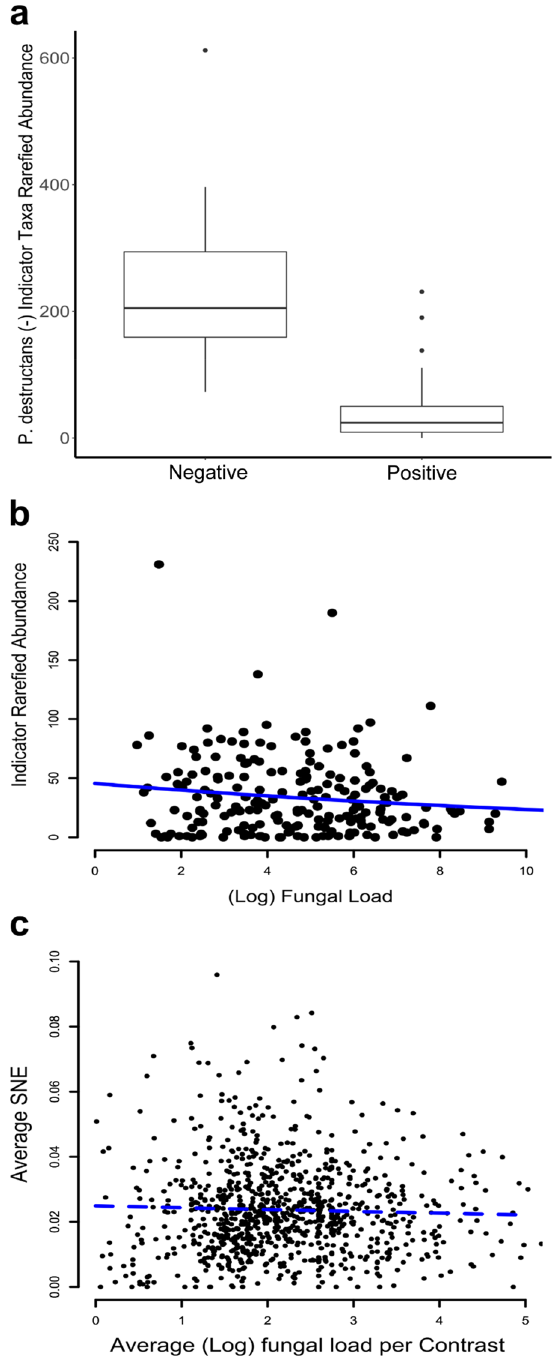
Figure 4. ( a ) Comparison of the rarefied abundance of P. destructans negative indicator taxa between P. destructans positive / negative samples. Indicator taxa are significantly more abundant within P. destructans negative samples (GLMM; z = − 62.84, p ≤ 0.05). ( b ) Comparison of the rarefied abundance of P. destructans negative indicator taxa by fungal load. There is a significantly negative relationship between indicator taxa rarefied abundance and amount of P. destructans present (GLMM; z = − 10.78, p ≤ 0.05). ( c ) Comparison of the (log) difference in average fungal load and average nestedness (SNE) of bats averaged by site. There is no significant relationship between similarity in fungal load and nestedness (GLM; z = − 0.10, p > 0.05). Graphs were produced using the ggplot2 package (version 3.3.2) in R 25